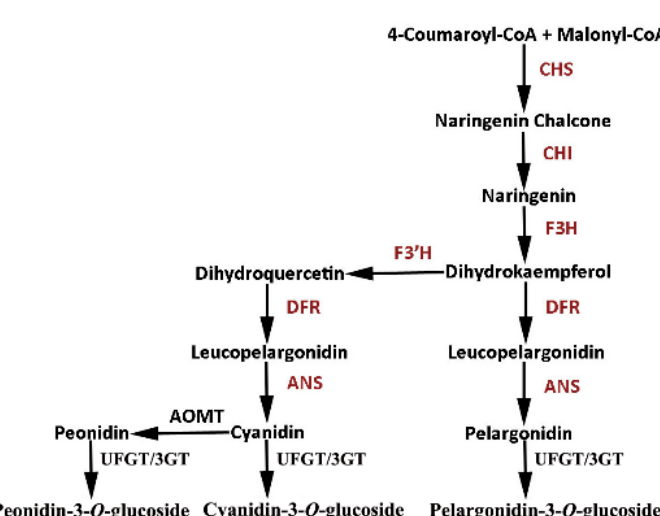
Figure 6. The metabolic pathway analysis of structural genes involved in anthocyanin biosynthesis of R. rugosa.